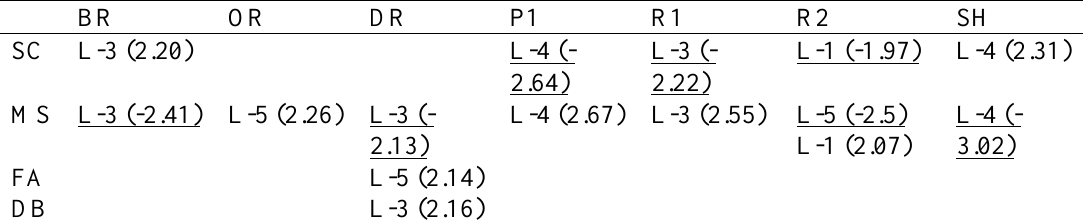
Table 5. Lag sequential analysis between the categories given of the dimension Consequence of the shot and the behaviours target corresponding to the dimensions Game action and Start of the sequence that ends in shot. In the left column are the given behaviours